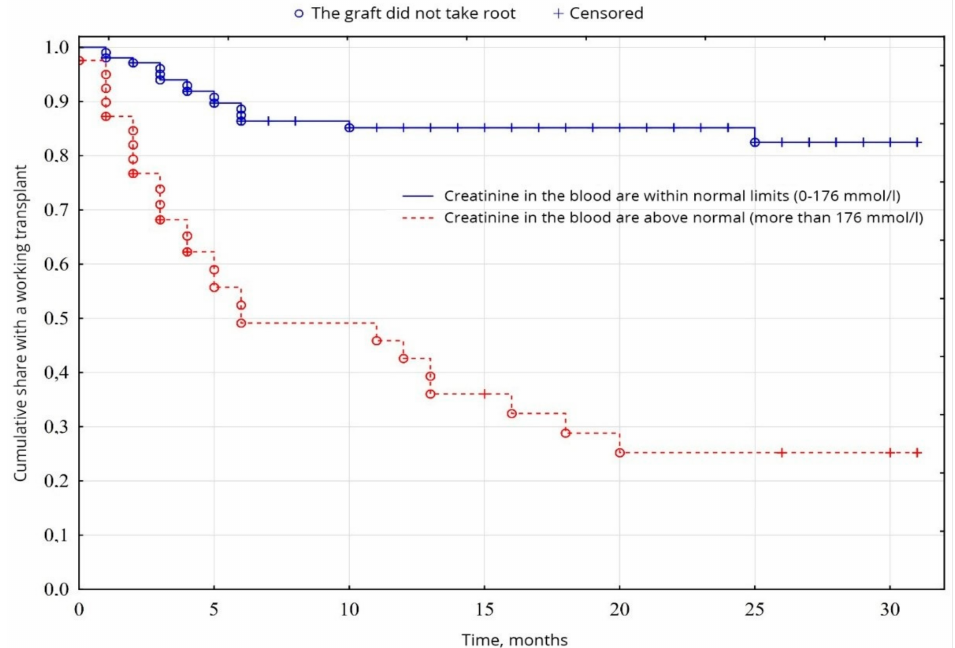
Figure 5. Evaluation of graft function depending on creatinine in the blood. From the indicators of the general analysis of urine, the indicators of proteinuria were probable ( p = 0.0005): the percentage of patients with increased proteinuria was 64.5% of patients, compared with 35.5% of patients with normal protein levels (Figure 7). The level of erythrocytes in the urine was probably ( p = 0.00001) higher in 34.8% of patients, compared with 65.2% of patients with erythrocytes within normal limits (Figure 8). No significant difference was found between other indicators of the general analysis of urine ( p <